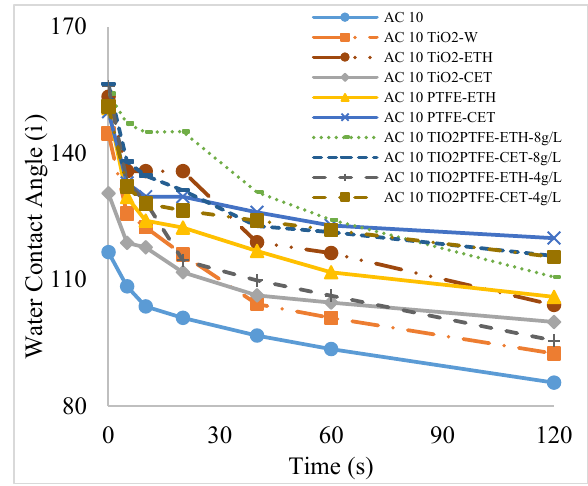
Fig. 2. Water Contact Angle